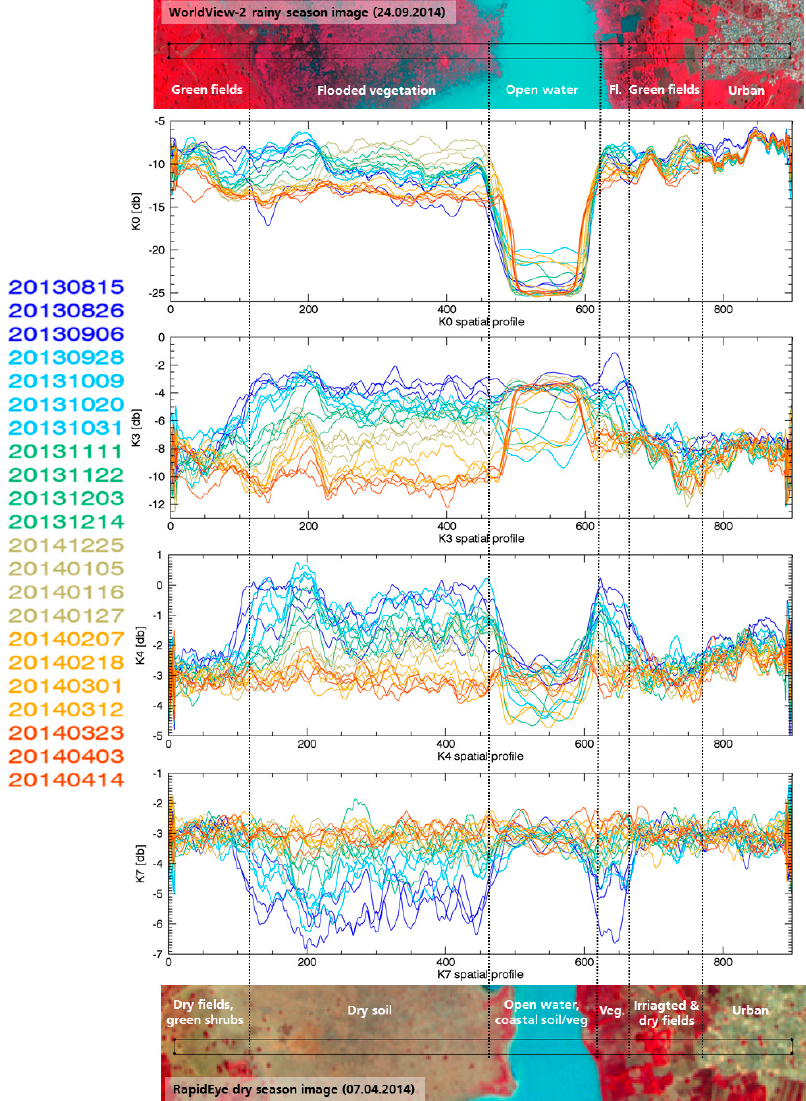
Figure 7. Spatio-temporal profiles for different land cover types along the spatial profile with time steps of TSX Kennaugh elements visualized in the color scale. Optical reference images from WorldView-2 (24 September 2014) (©DigitalGlobe 2014 provided by EUSI, Westminster, CO, USA), and RapidEye (7 April 2015) (©BlackBridge 2014, Berlin, Germany) define the land cover during the start and end point of the temporal